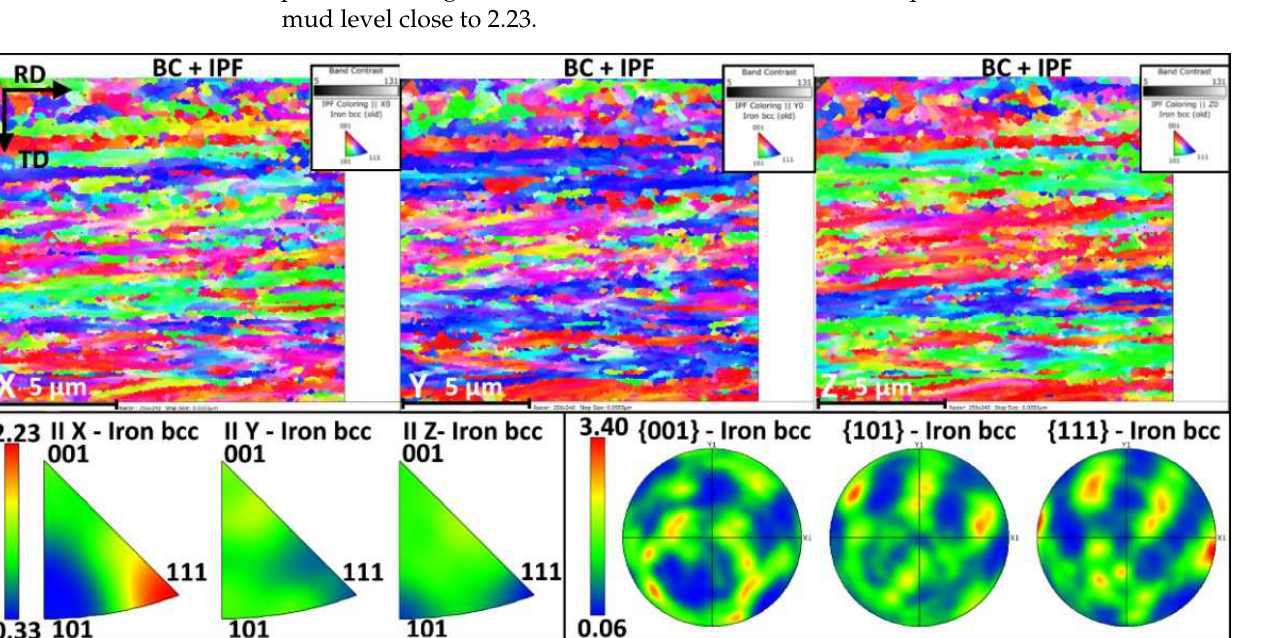
Figure 6. Bainite fragmentation: carbides appear more homogenously distributed as the strain hardening level is increased.